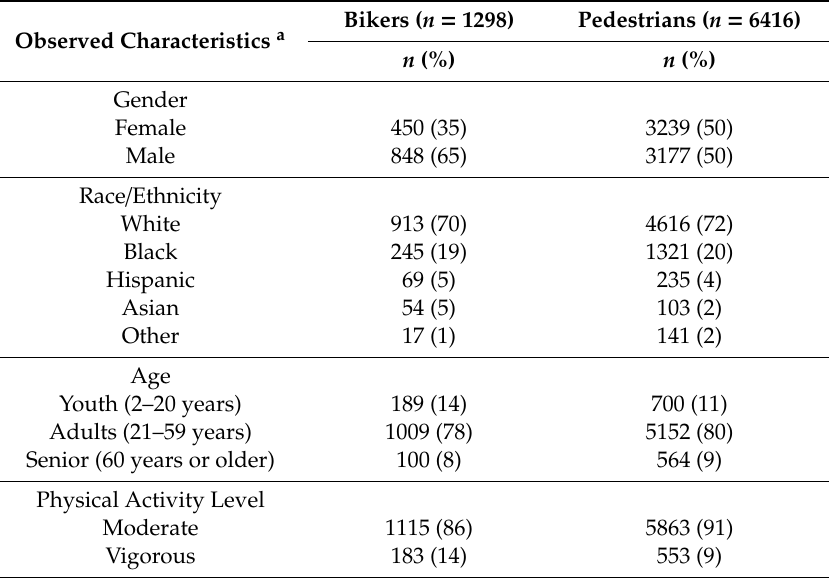
Table 2. Characteristics of greenway ssers in Winston-Salem, NC.